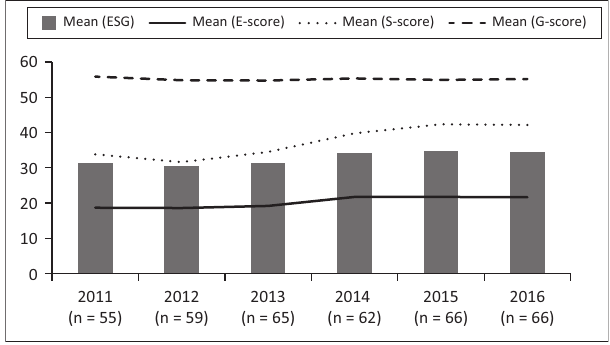
FIGURE 1: Annual mean values for the composite and individual environmental, social and corporate governance disclosure scores. TABLE 3: Summarised regression results for the sample companies. Panel Preferred model † Return on